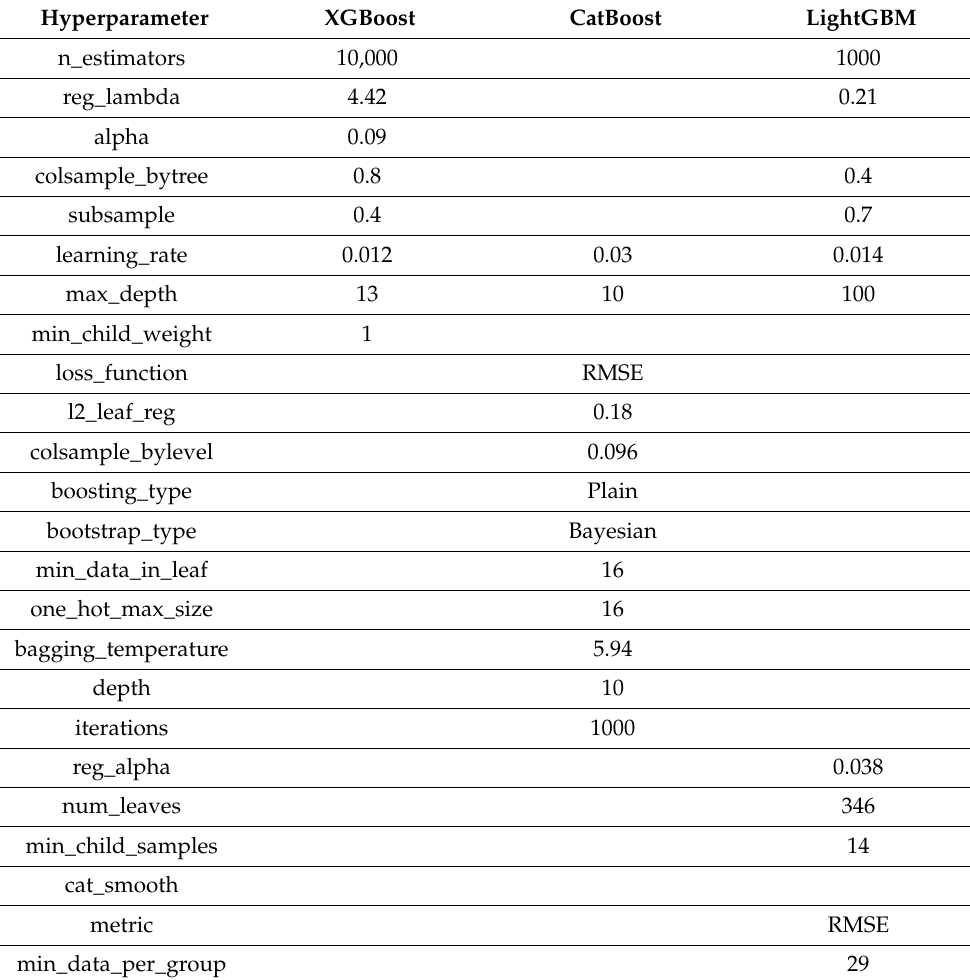
Table 2. The optimum hyperparameter values for the XGBoost, CatBoost and LightGBM models trained on the reconstructed data by the